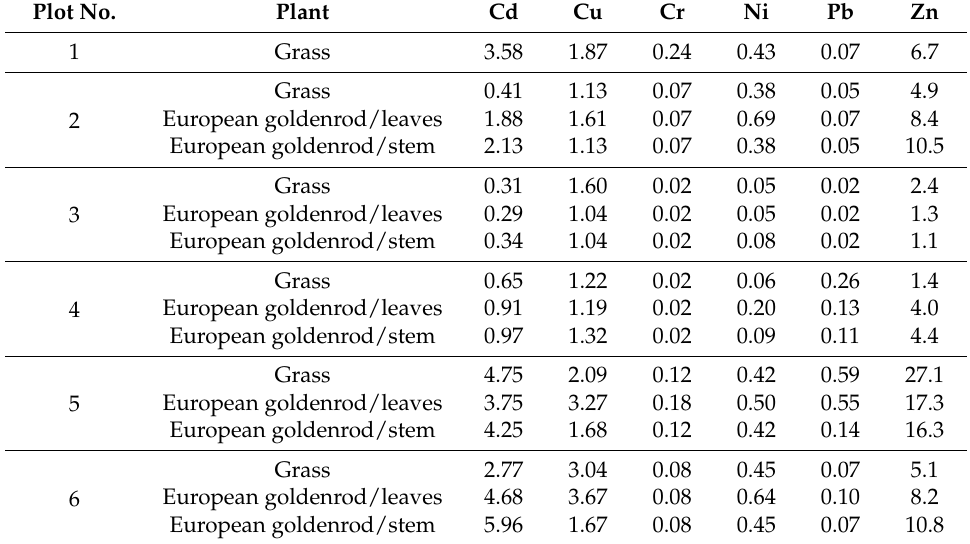
Table 5. Values of the phytoaccumulation coefficient—BAC (ratio of the metal concentration in plants to metal concentration in soil (0–25 cm)) in the area of the municipal solid waste Łubna landfill. Plot No. Plant Cd Cu